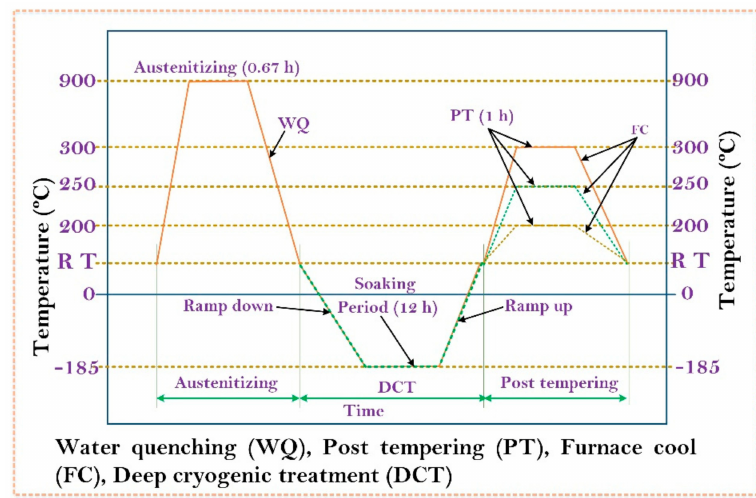
Figure 2. Thermal treatment